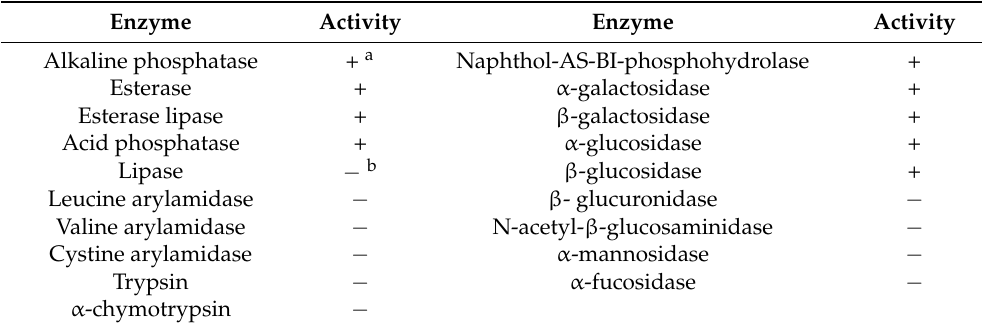
Table 8. Enzyme activities of B. subtilis IDCC1101.